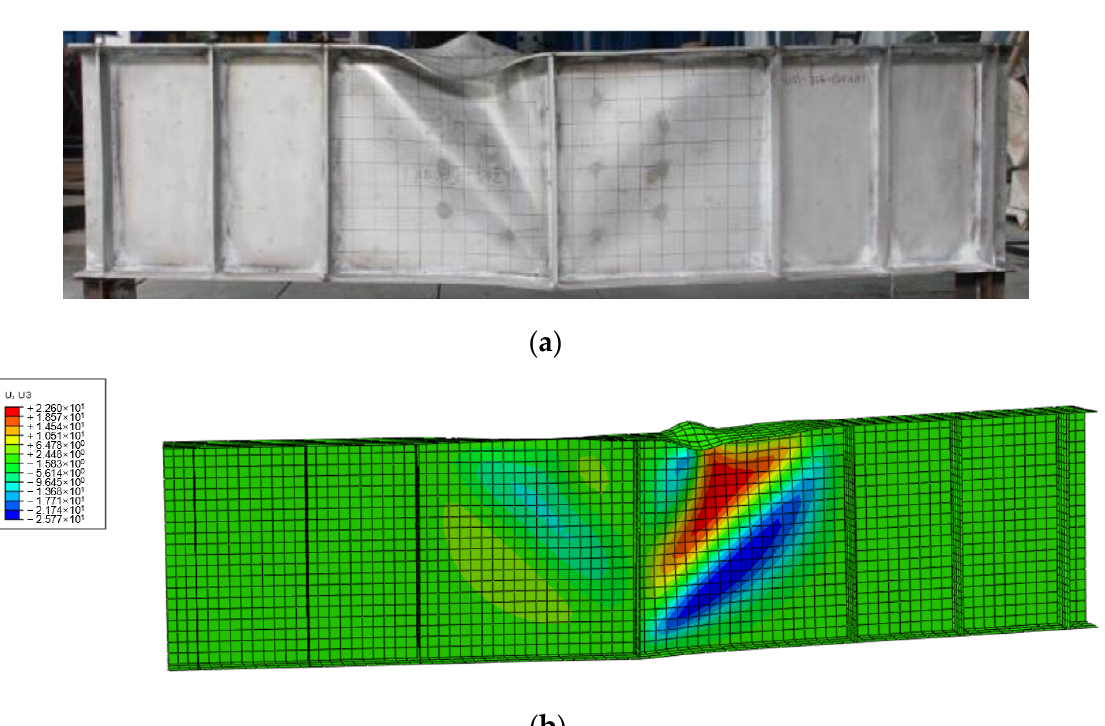
Figure 8. Failure behaviors comparison: ( a ) experiment specimen [54]; ( b ) FE model in this study.